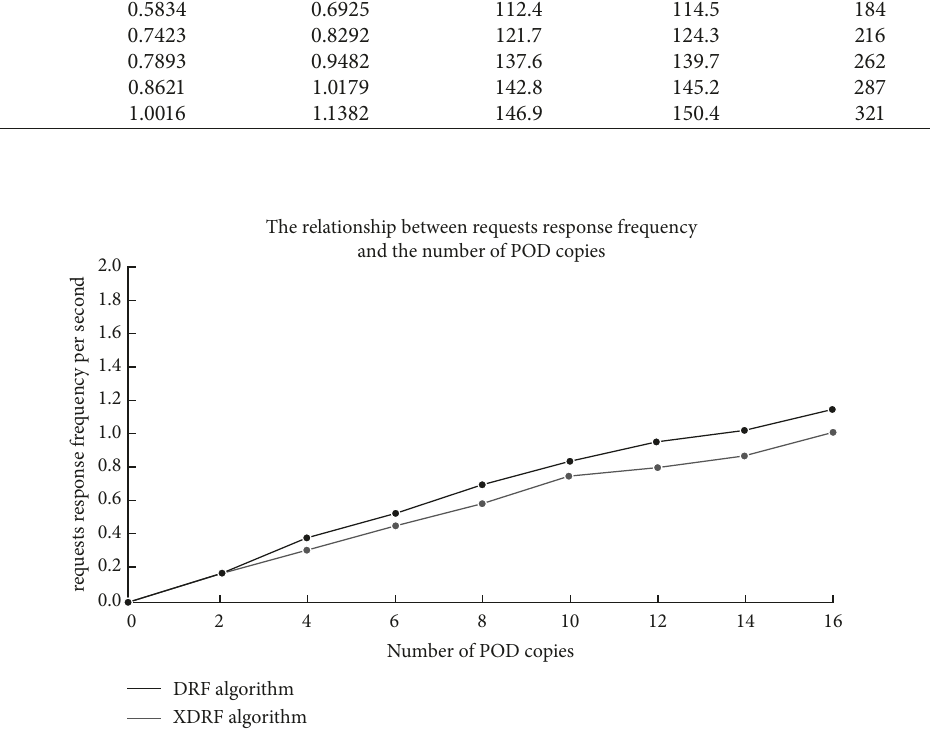
Figure 2: The relationship between XEDI request-response frequency and the number of POD copies.